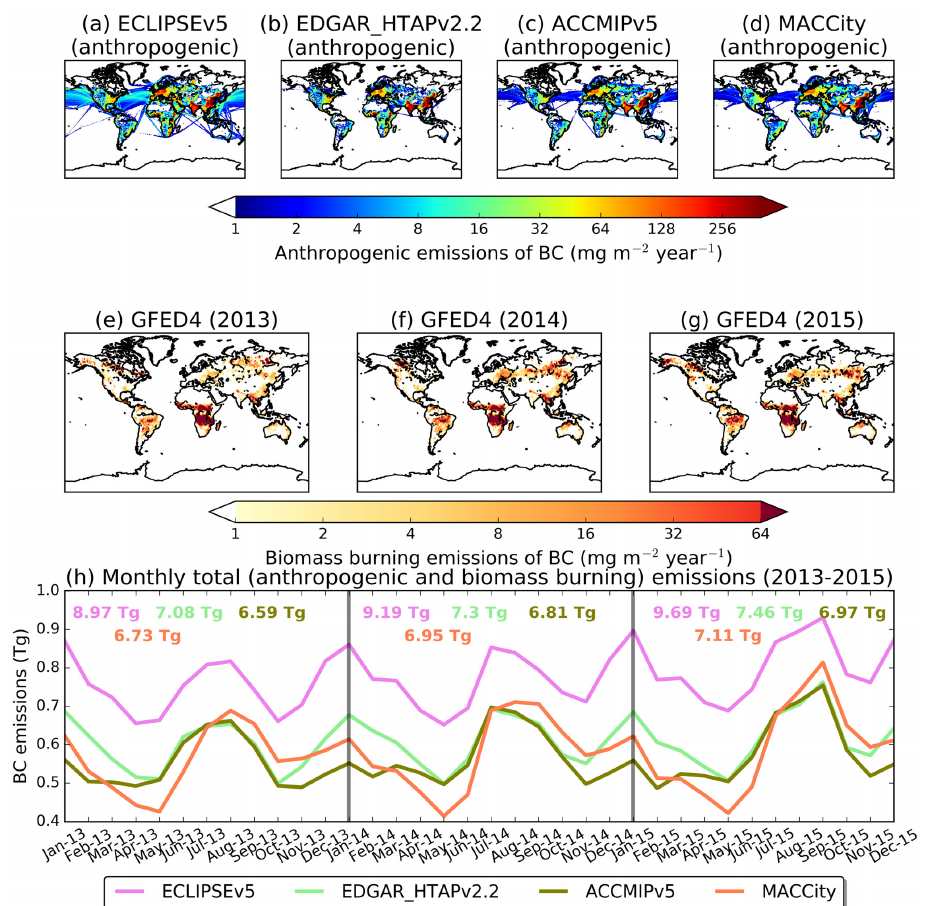
Figure 2. (a–d) Anthropogenic emissions of BC in the inversion domain (>50 ◦ N) from ECLIPSEv5, EDGAR_ HTAPv2.2, ACCMIPv5 and MACCity (anthropogenic emissions are assumed to be constant throughout every year). (e–g) Biomass burning emissions from GFED4 for 2013, 2014 and 2015 (Giglio et al., 2013). (h) Monthly total (anthropogenic and biomass burning) BC emissions north of 50 ◦ N from 2013 to 2015 from the four prior inventories used for the inversion. Coloured numbers correspond to total annual BC from each emission